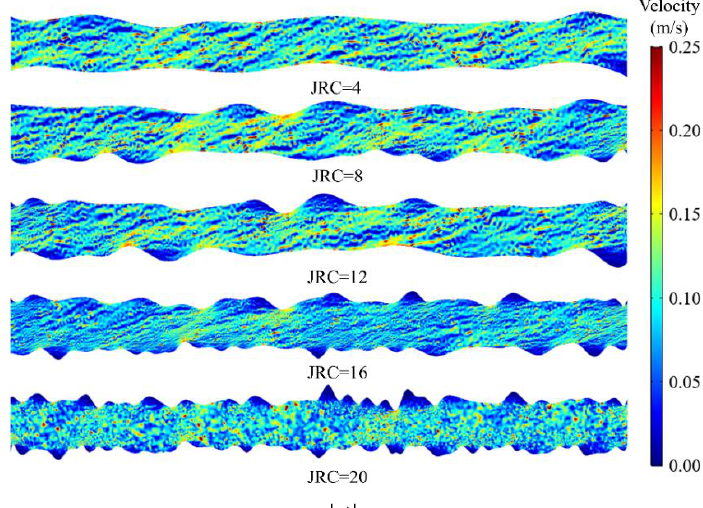
ff erent JRCs at 30